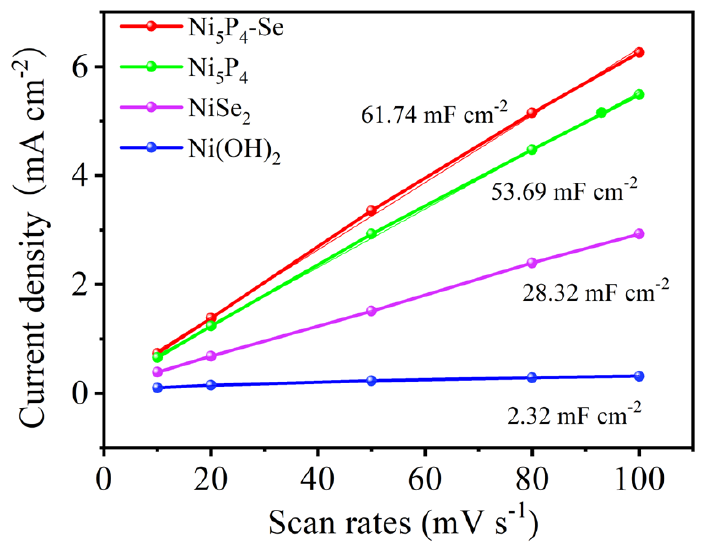
Figure 5. The C dl values of Ni(OH) 2 , Ni 5 P 4 , NiSe 2 , Ni 5 P 4 − Se.